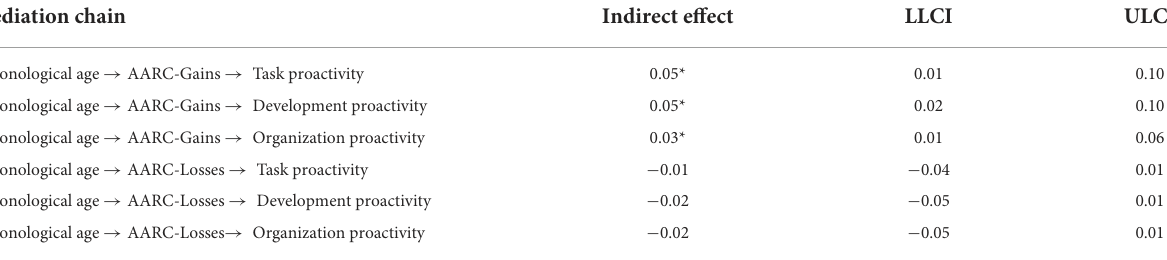
TABLE 6 The mediating role of both dimensions of AARC in the three chronological age–proactivity